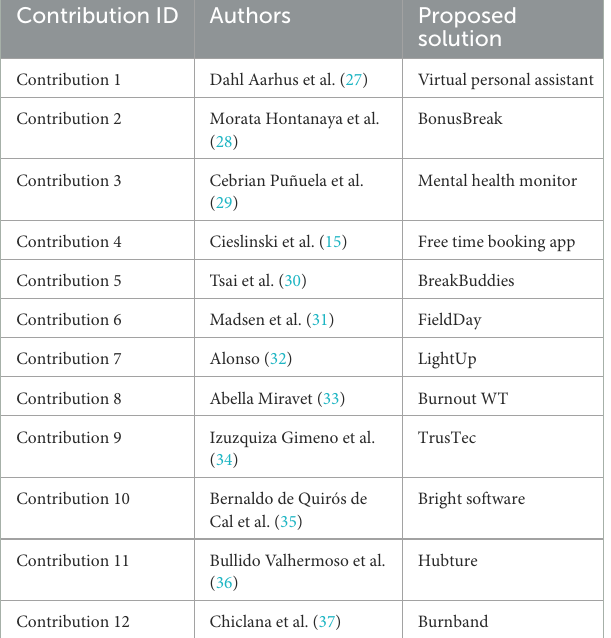
TABLE 1 List of proposed creative projects—technological